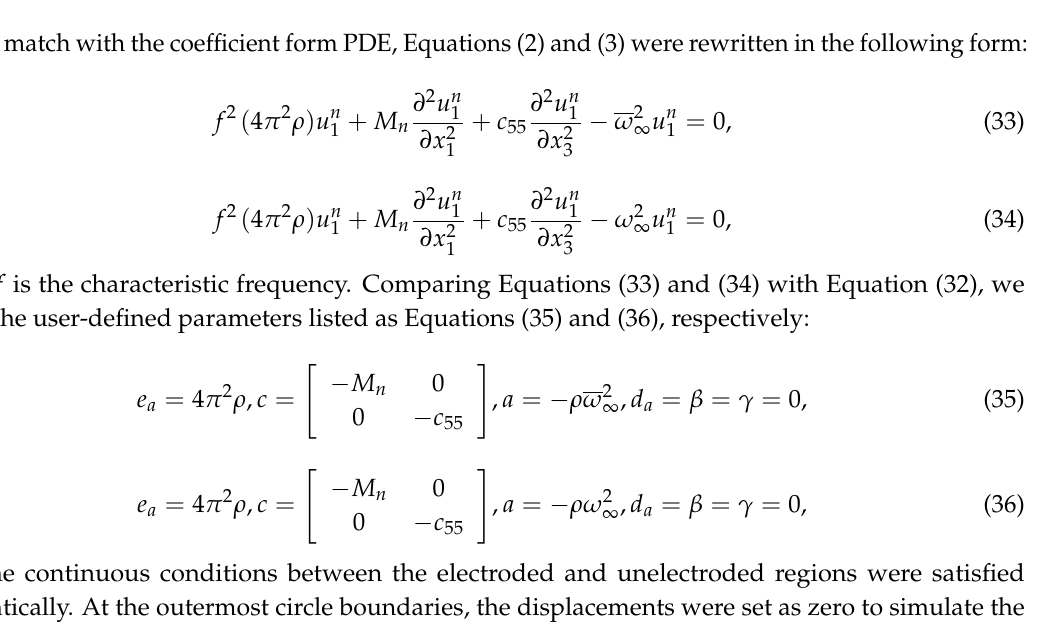
Figure 5. The meshed infinite electrode model.